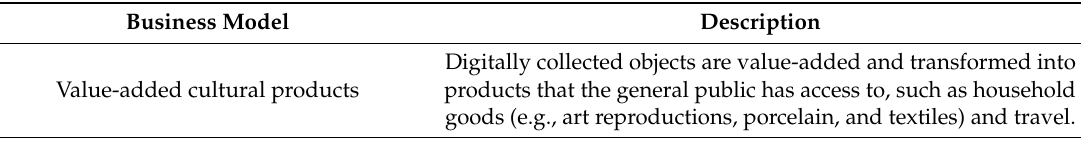
Table 1. Five business models of digital